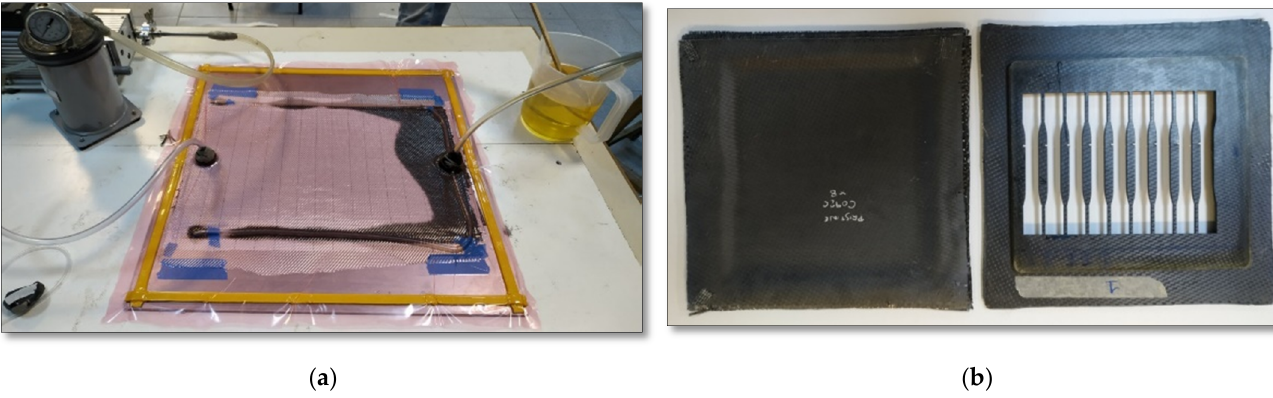
Figure 1. ( a ) VA-RTM for composite manufacturing, ( b ) Composite panel manufactured through VA-RTM (left) and scrap remained after cutting